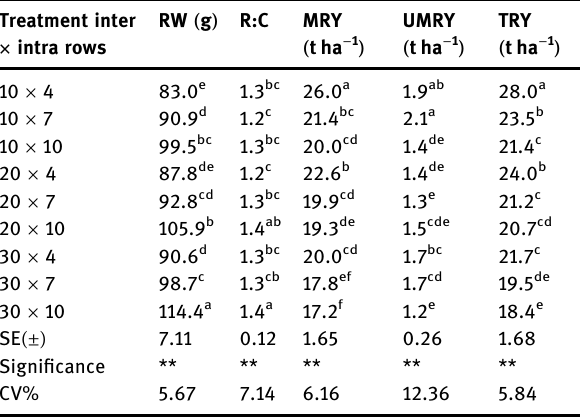
Table 3: Inter and intra row interaction e ff ects on yield and yield component of carrot as combined over locations and years Treatment inter × intra